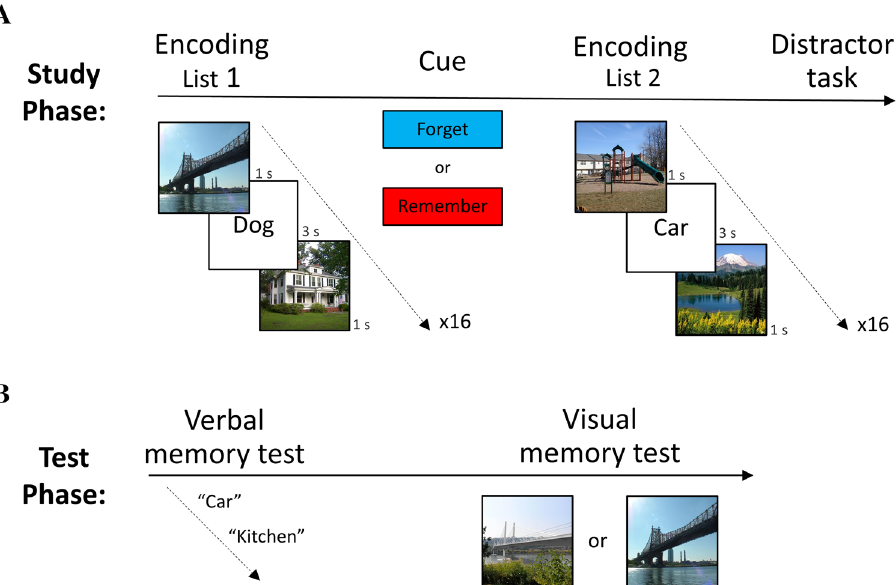
Figure 1. Indirect visual memory modulation experimental design ( A ) Participants were presented with two lists of words intermittently presented between pictures which were the actual target for indirect visual memory modulation. A cue was presented to either forget or remember the first list of words. ( B ) Following encoding, memory strength was tested for the words (direct memory modulation), and the pictures (indirect visual memory modulation). Pictures illustrated are from FIGRIM, a publically available database 54